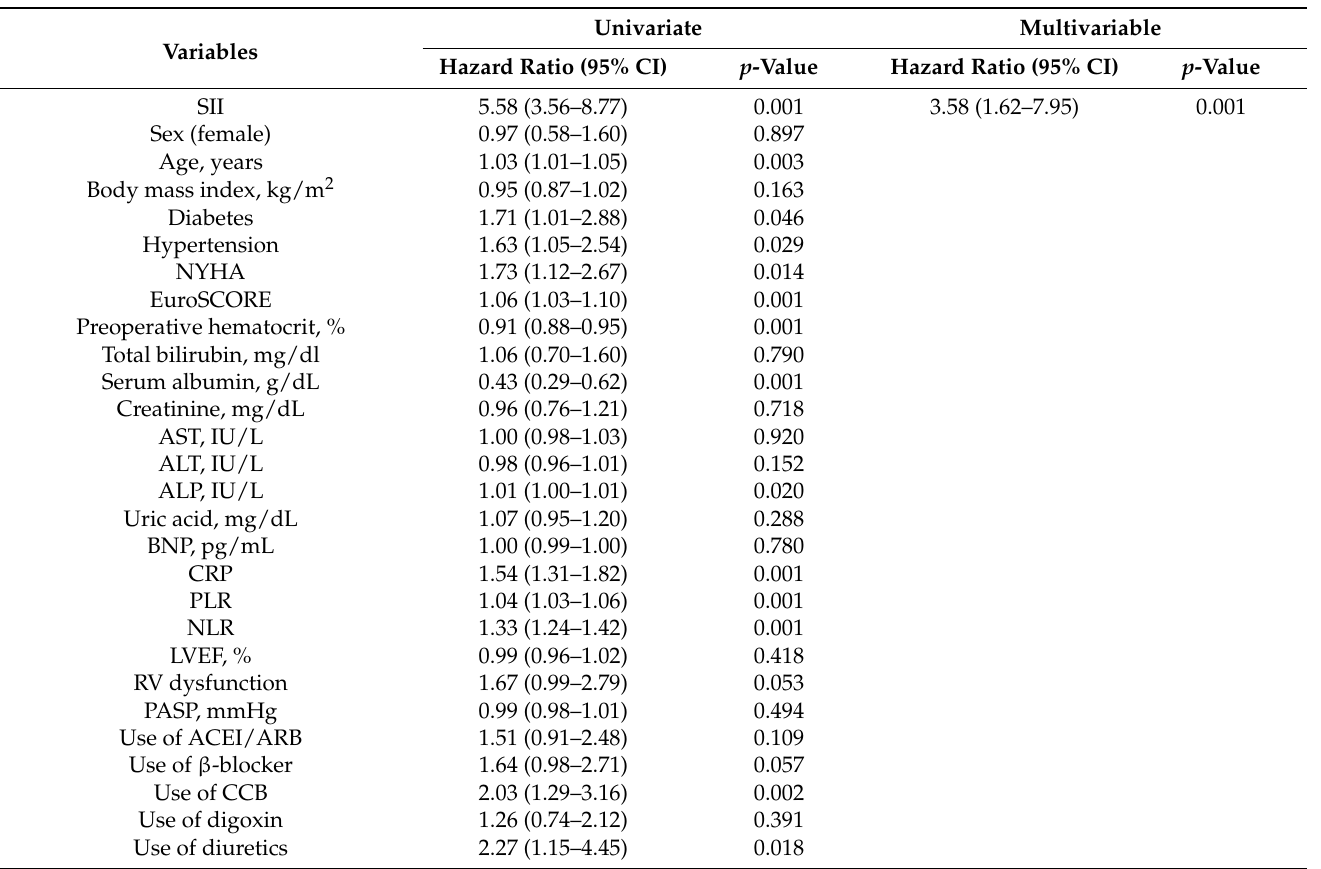
Figure 3. Kaplan–Meier curves for the probability of major postoperative complications between patients with different SII groups; SII, systemic immune-inflammation index; Low SII group, red; High SII group, blue. Table 3. Predictors associated with composite 30-day major postoperative complications in patients undergoing isolated tricuspid valve